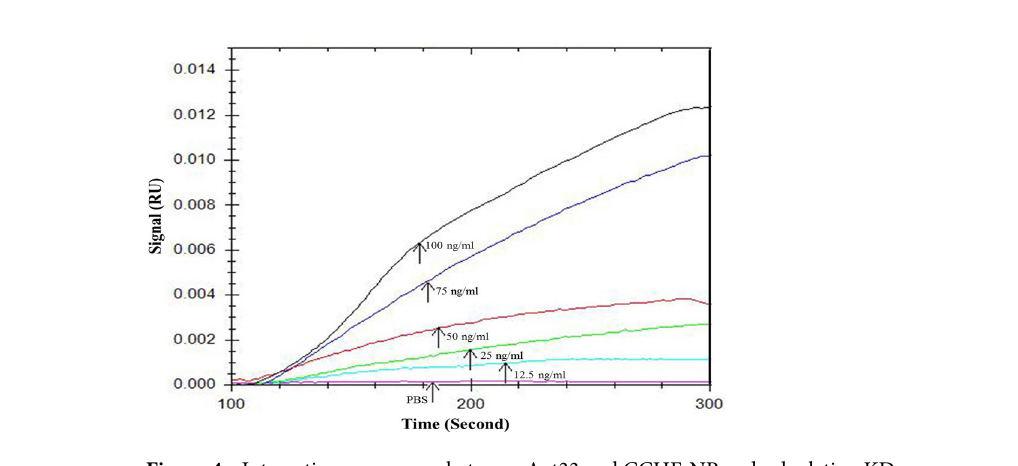
Figure 4. Interaction sensogram between Apt33 and CCHF-NP and calculating KD.